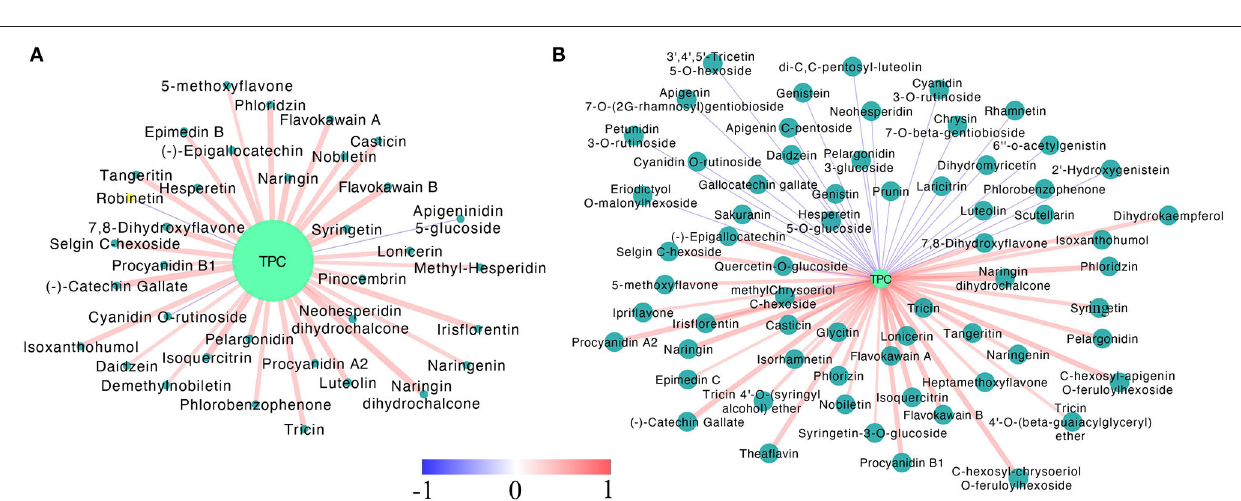
( Figure 6E ), which might be caused by the different